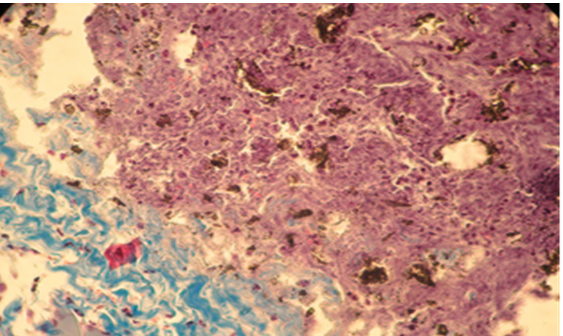
Figure 8. Moderate necrosis area with pockets of implanted material and moderate leukocyte influx. Partial resorption of the implant material. Subcutaneous tissue, 7 days after implantation. Col. Trichrome Masson, × 200.